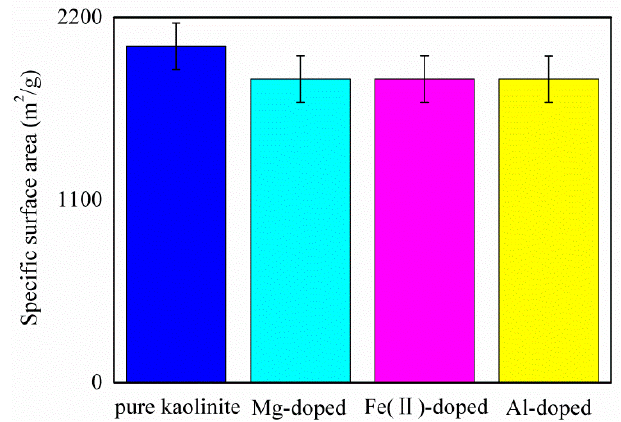
Figure 3. The histogram of the specific surface area of pure and Mg-, Fe(II)-, and Al-doped kaolinite. Error bars indicate the standard deviations.